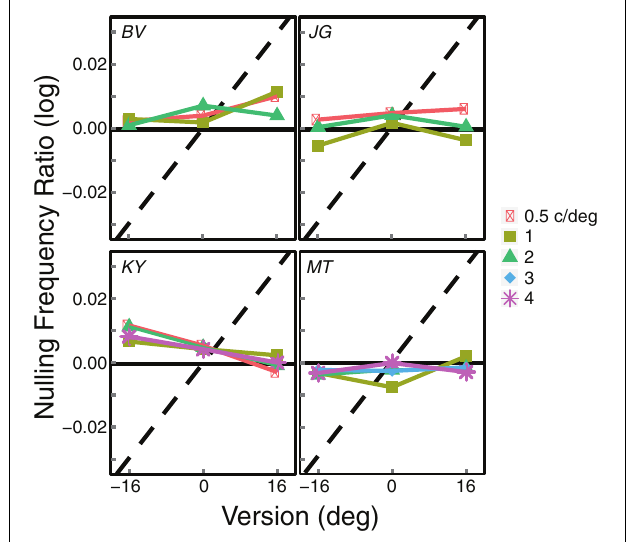
FIGURE 5 | Summary results from Experiment 1. Each panel shows the results from an individual observer. The logarithm of the average of the inter-ocular frequency ratios that produced visible blinds (that is, the average of the 50% points on the two cumulative Gaussians fit to the psychometric data) is plotted as a function of gaze direction. Different symbols represent the data from different average spatial frequencies. The black horizontal lines represent the predicted values if the frequency ratio at which blinds were perceived is based on disparity. The dashed diagonal lines represent the predictions if blinds perception is based on slant; those predictions differ slightly across observers because of their differing inter-ocular